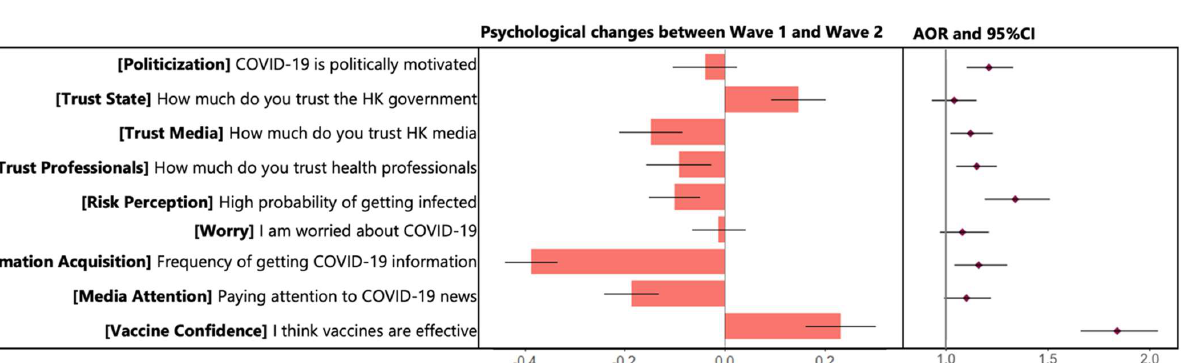
tions between vaccination and perceptual/attitudinal factors at the zero-order and after likely to demonstrate weaker issue politicization (AOR = 0.77), greater trust in state au-